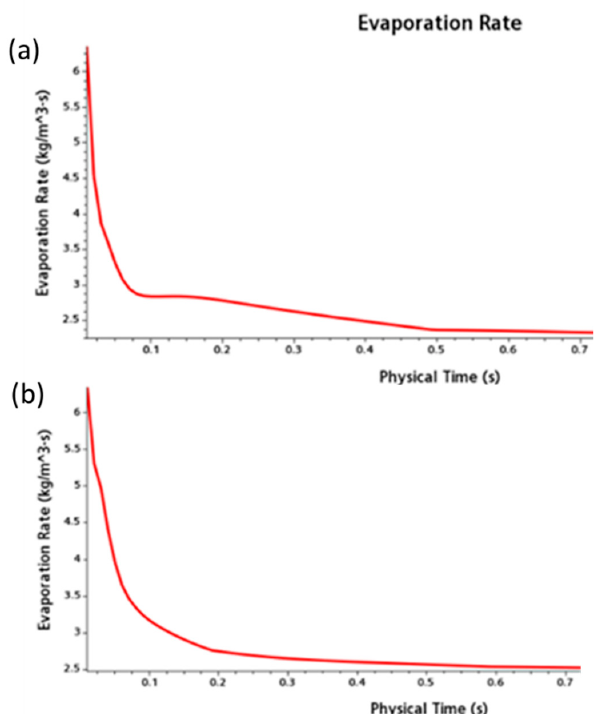
Figure 7. Evaporation rate plot vs. time extrapolated from the CFD simulation. ( a ) Nero Spinoso, ( b ) control maize (B73/Mo17 hybrid).